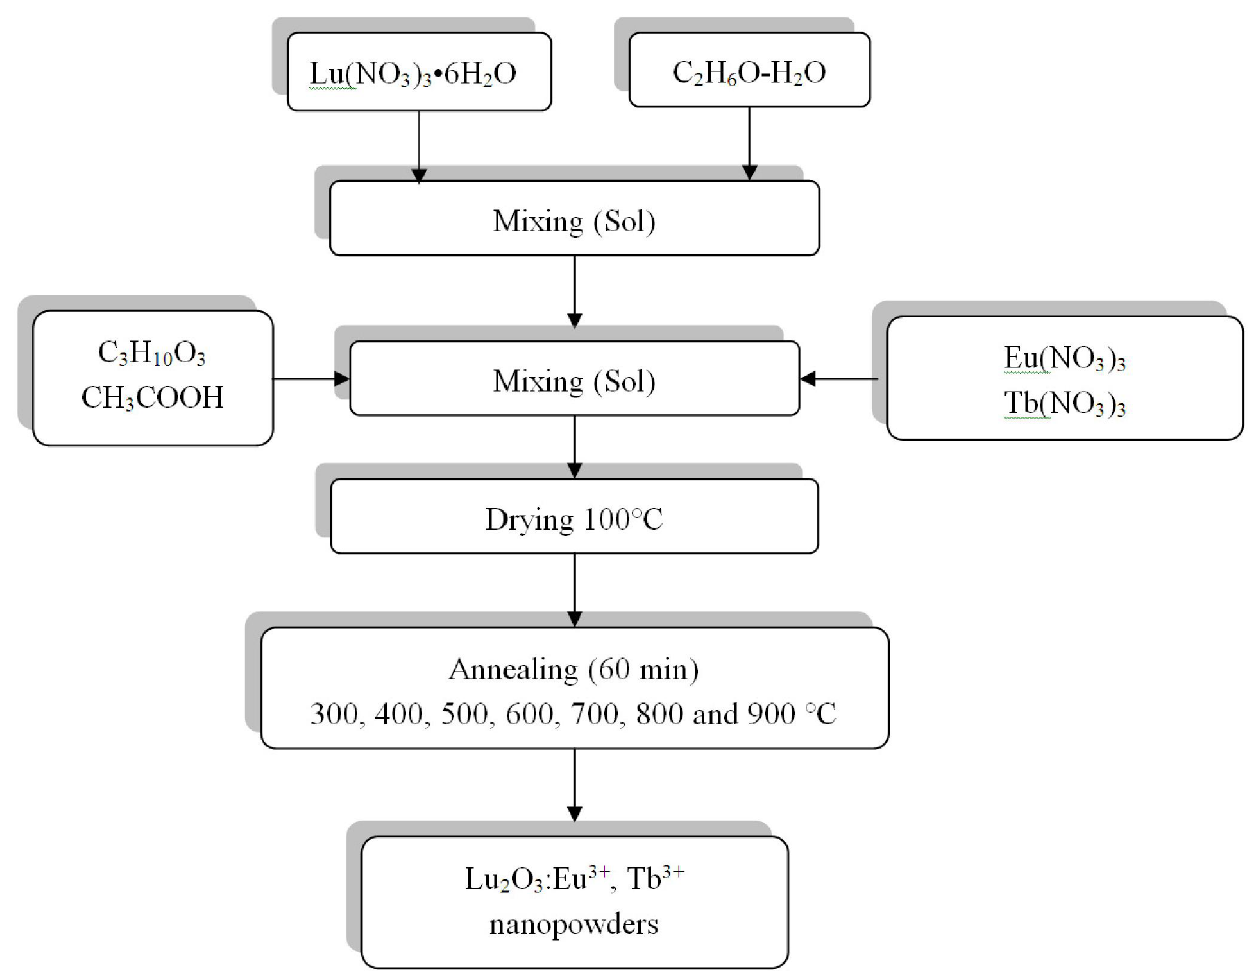
O :Eu 3+ , Tb 3+ nanopowders synthesis 2 3